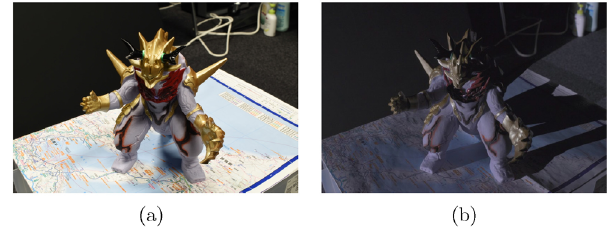
Fig. 2 (a) Example of the multi-view images with ambient lighting for acquiring geometry. (b) Example of a few additional images with one distant light for acquiring reflectance. Note that (a) and (b) were captured from the same